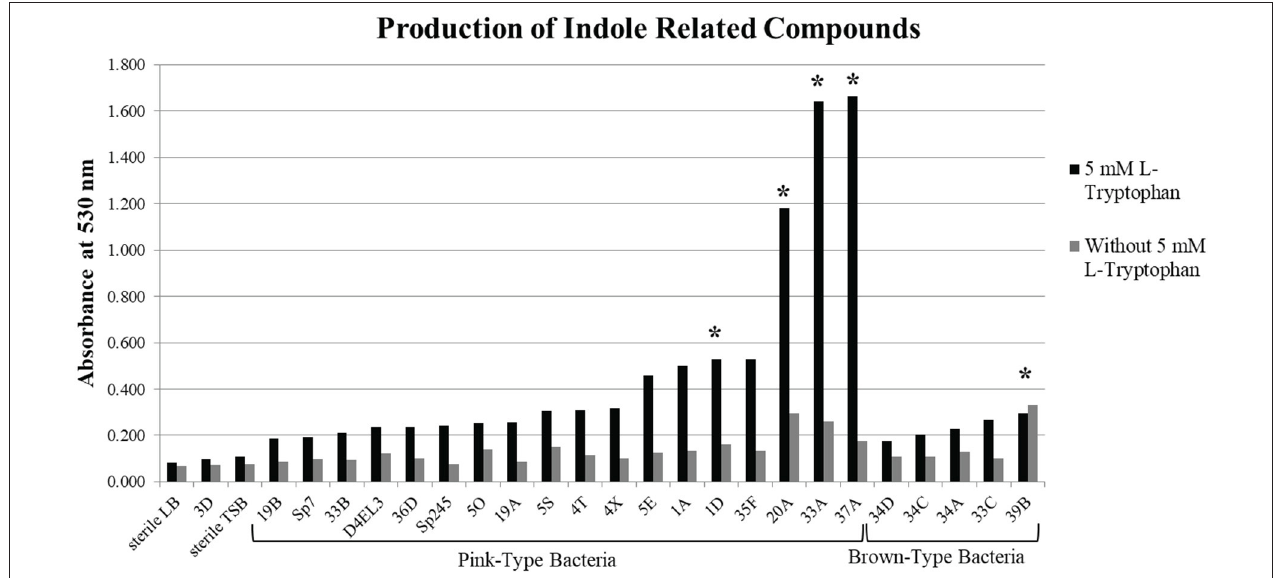
FIGURE 1 | Production of indole related compounds from duckweed associated bacteria strains. Addition of Salkowski reagent to the bacterial supernatant of a subset of the pink-type and brown-type bacteria strains grown in medium with and without 5mM L-tryptophan to measure the absorbance of indole related compounds at 530nm. *Indicates that the supernatant without 5mM L-tryptophan resulted in an observable color